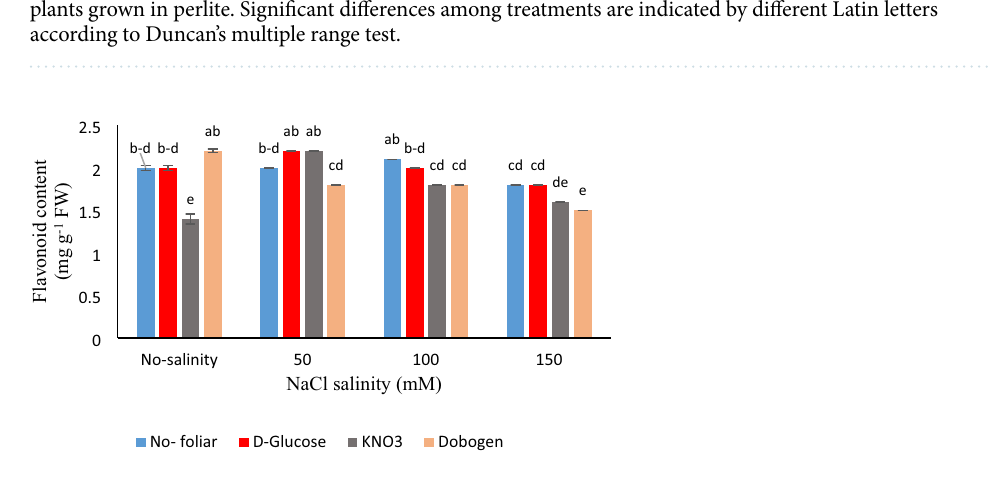
Figure 3. Interaction effects of salinity (0, 50, 100, and 150 mM NaCl) and foliar applications (no-foliar, 2 g L −1 glucose, 2 g L −1 KNO 3, and 2% Dobogen biostimulant) on flavonoids content of Tanacetum balsamita plants grown in perlite. Significant differences among treatments are indicated by different Latin letters according to Duncan’s multiple range